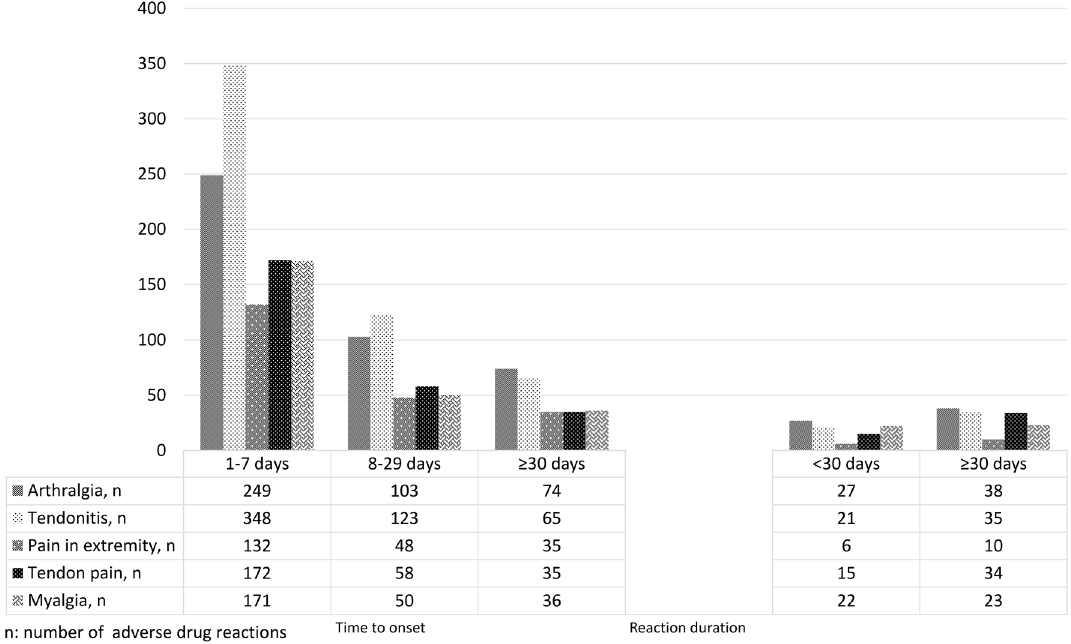
Figure 4. Time to onset and reaction duration of the topmost frequent FQ-musculoskeletal ADRs with available information. ADRs adverse drug reactions; FQ fluoroquinolone. Data presented for the ADRs that had this information available; More than one ADR could be reported per report.